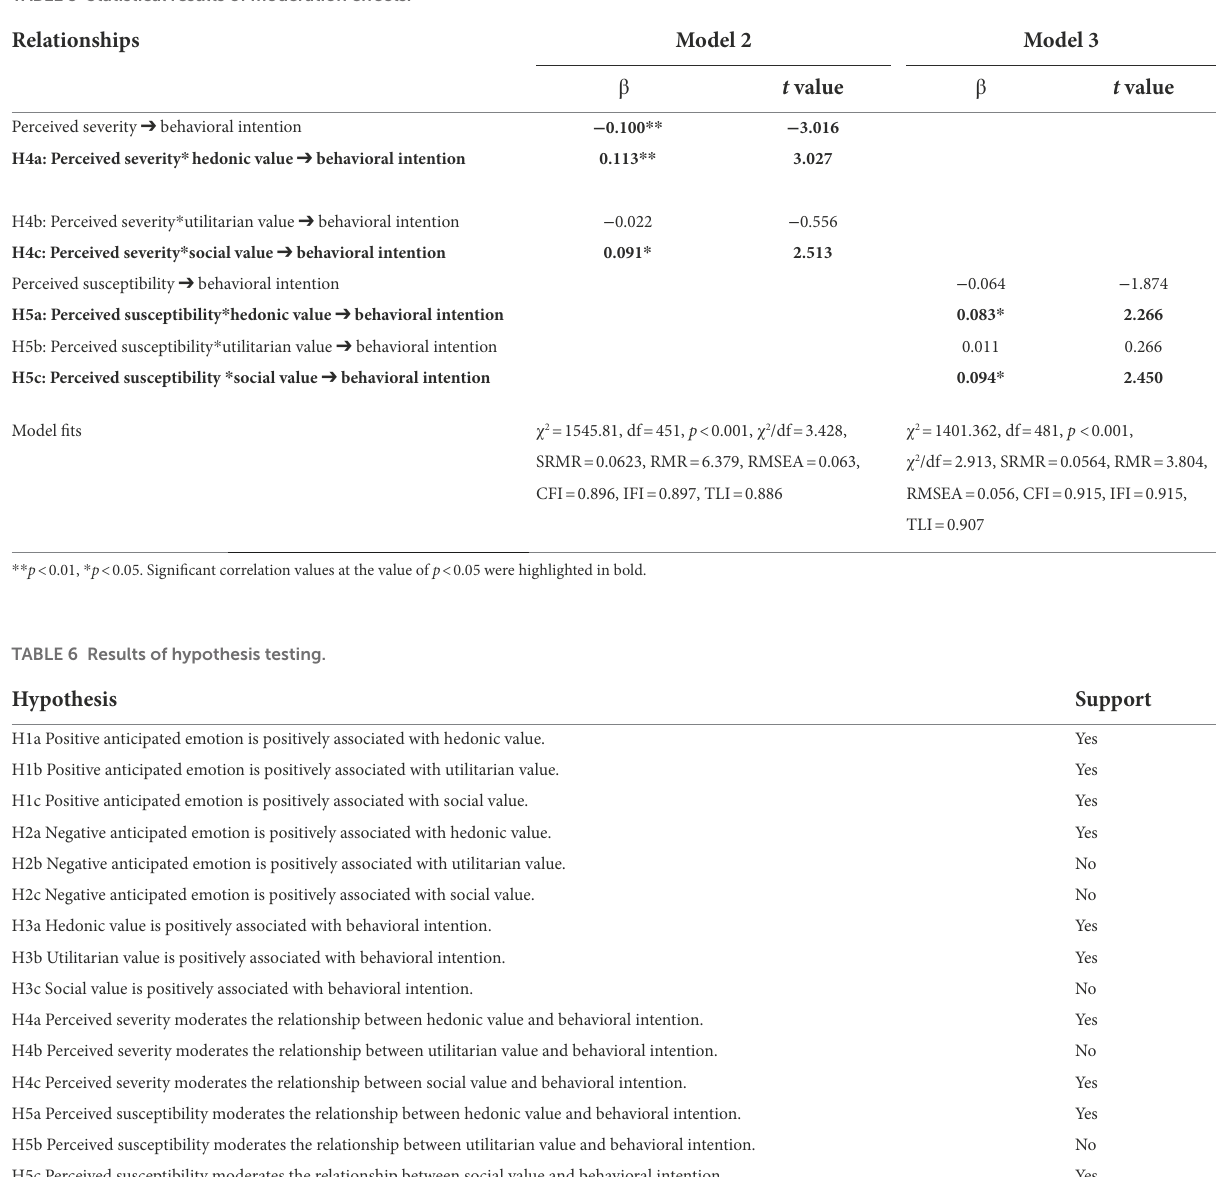
TABLE 5 Statistical results of moderation effects.